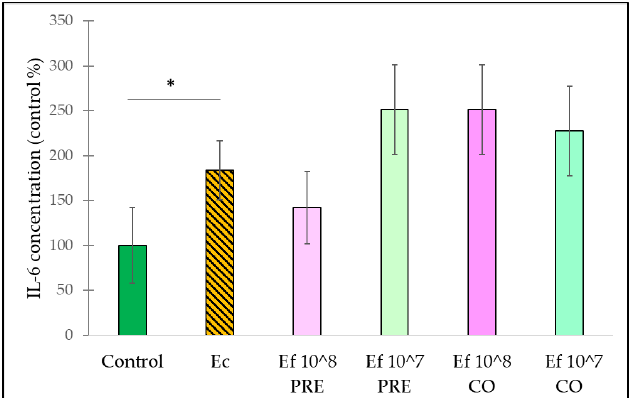
Figure 6. Induction of IL-6 secretion of IPEC-J2 cells after stimulation with E. coli and E. faecium . E. faecium was added 1 h before (pre-treatment) or at the same time (co-treatment) of the addition of E. coli . E. faecium was added in 10 8 CFU/mL or in 10 7 CFU/mL concentration. Control : plain cell culture medium treatment; Ec : E. coli 10 6 CFU/mL; Ef 10^8 PRE : pre-treatment with E. faecium 10 8 CFU/mL + E. coli 10 6 CFU/mL; Ef 10^7 PRE : pre-treatment with E. faecium 10 7 CFU/mL + E. coli 10 6 CFU/mL; Ef 10^8 CO : co-treatment with E. faecium 10 8 CFU/mL + E. coli 10 6 CFU/mL; Ef 10^7 CO : co-treatment with E. faecium 10 7 CFU/mL + E. coli 10 6 CFU/mL. Data are shown as means with standard deviations, n = 6/group. * p ≤ 0.05.